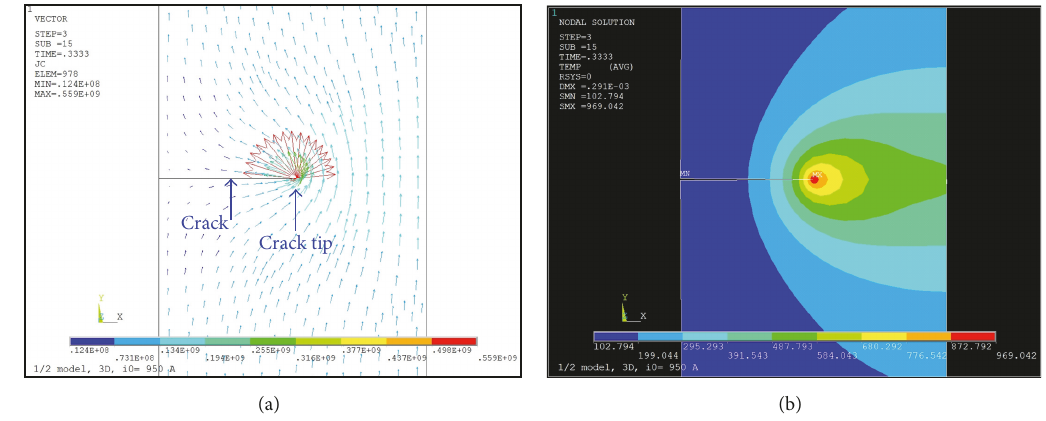
Figure 5: (a) Electric current density field (units: A/m 2 ). (b) Temperature field (units: ∘ C).